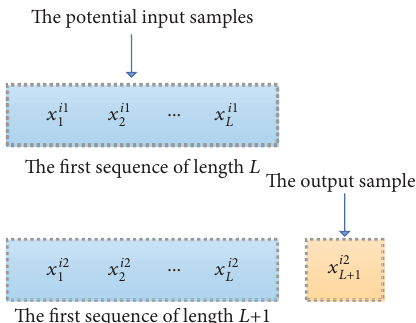
Figure 1: The input and output samples.